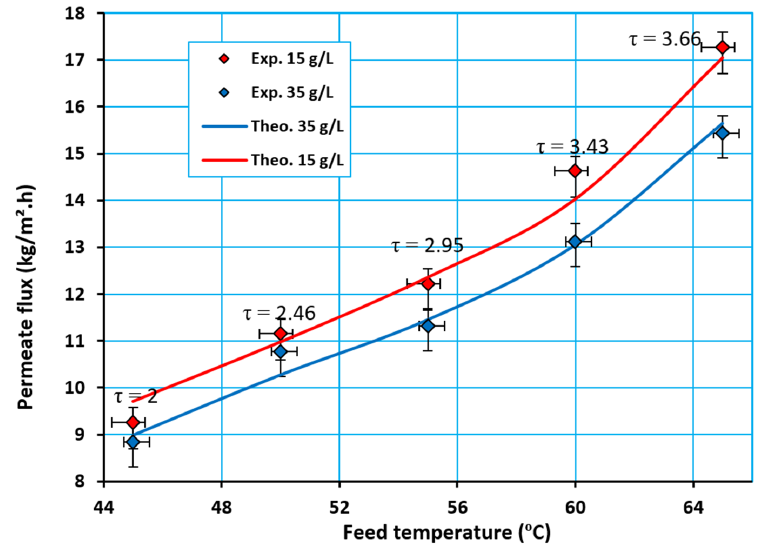
Figure 12. Influence of the feed temperature on the permeation flux at a feed concentration of 15 and 35 g/L NaCl at a feed flow rate of 1.07 L/min.